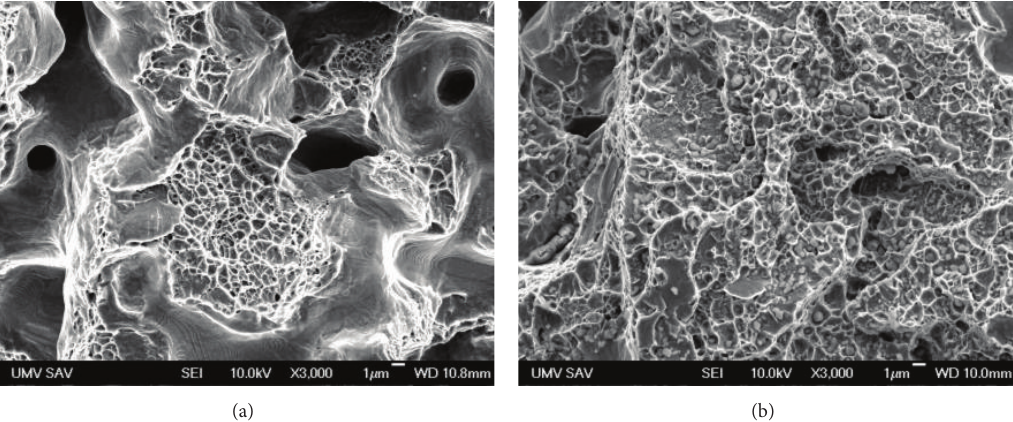
Figure 9: Fracture surface of the fractured AstCrM + 0.5% C components with densities of (a) 6.5 and (b) 7.4 g/cm 3 sintered at 1200 ∘ C for 30